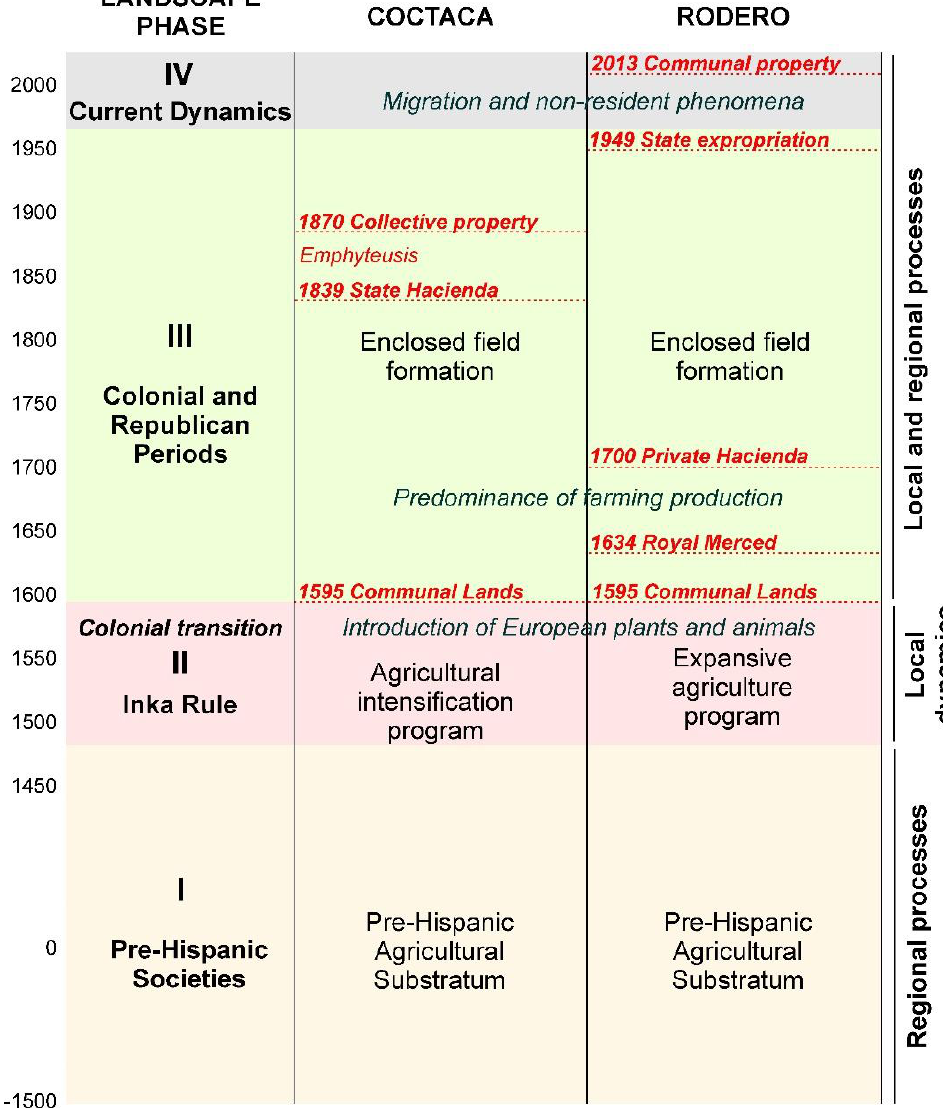
Figure 2. Chronology of the main landscape phases in the sites of Coctaca and Rodero. Although the pre-Hispanic agricultural substrata of both districts share many general characteristics, they do differ in some sectors. For example, most of the large terraced areas located in the localities of Pucara and Ronque are not delimited by the perimeter clearings seen in other places. Beyond Coctaca and Rodero, this same pre-Hispanic agricultural substratum appears in other parts of the Quebrada de Humahuaca, such as in Capla and Alfarcito on the eastern slopes, Raya Raya and Estancia Grande on the western slopes, and in Atumpa to the north of the Quebrada de Humahuaca (Figure 4). An area with similar characteristics is located some 100 km further south, in the high altitude valleys of Morohuasi and Incahuasi in the Province of